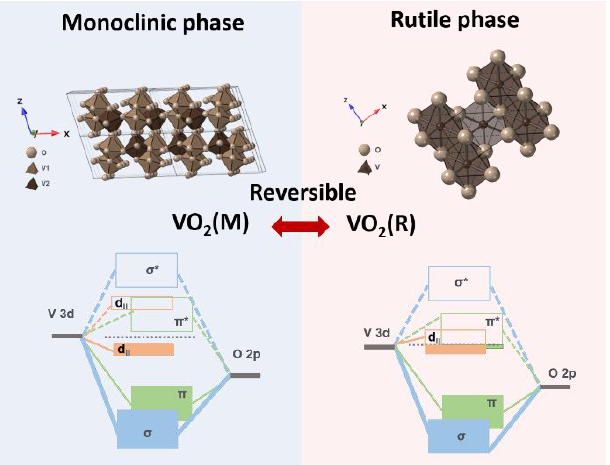
Figure 1. Schematic of the crystal structure and electronic band structure of the insulating VO 2 (M) and the metallic VO 2 (R). Adapted with permission from [13]. Copyright 2011, American Chemical